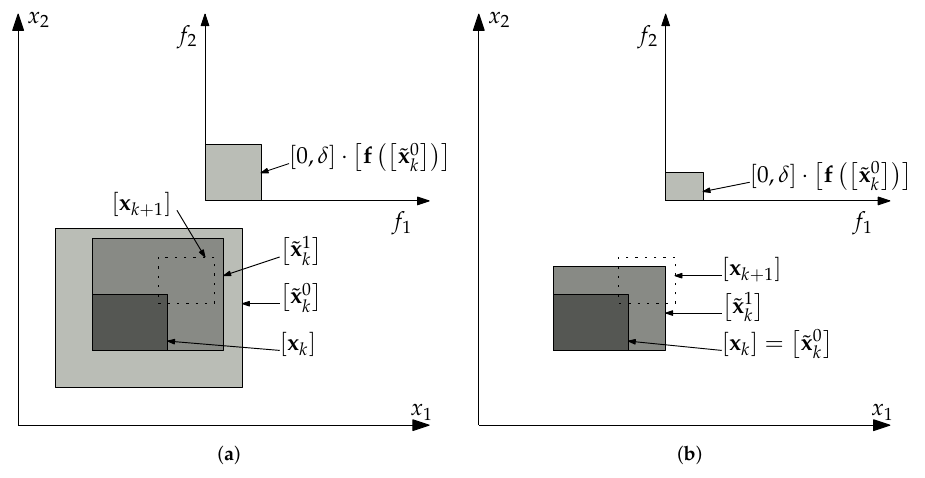
(cid:2) (cid:3) (cid:54)⊂ (cid:2) (cid:3) ˜ x 1 ˜ x 0 . ( b ) Second iteration: k k